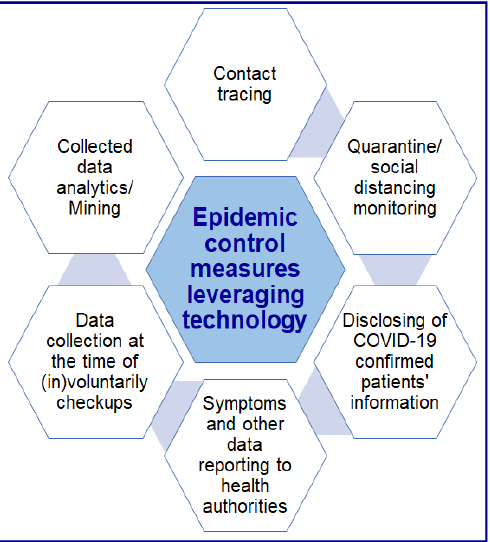
Figure 3. Overview of the pertinent epidemic control measures leveraging